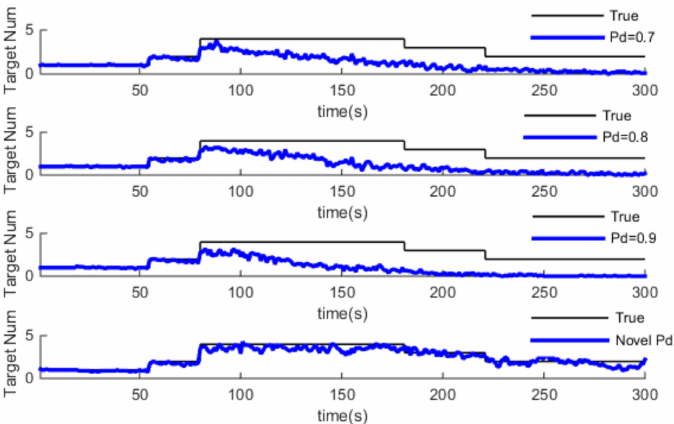
Figure 6. Comparison of target number estimation with different P d in clutter intensity κ k = 5.